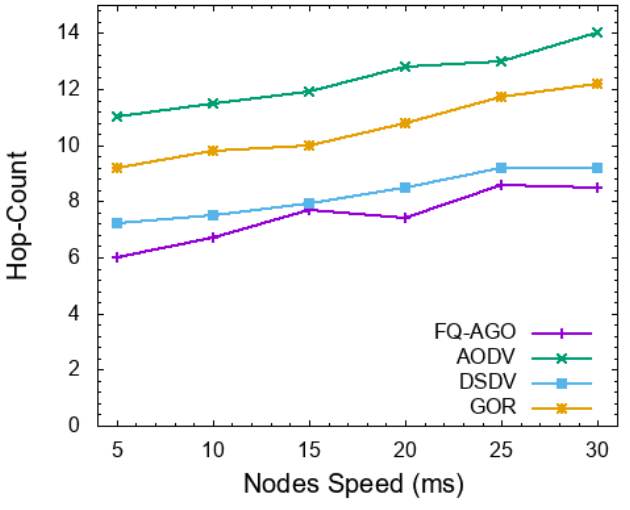
Figure 7. Hop-Count vs. nodes